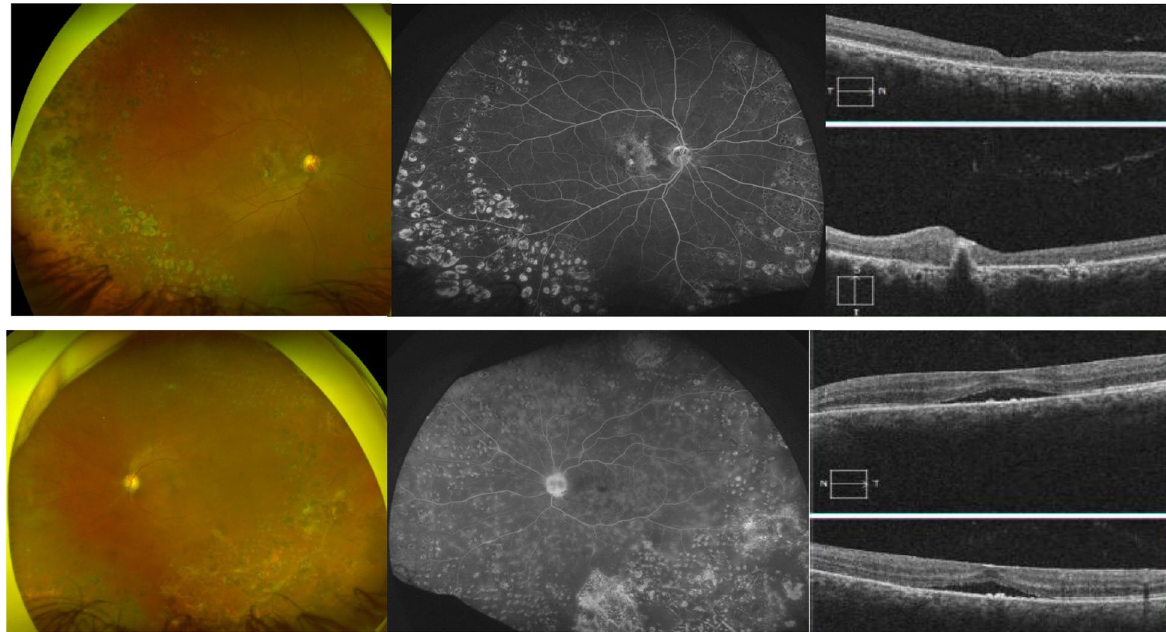
Fig. 2 Last follow up Fundus photo, FFA and OCT). Upper column ( right eye): wide field fundus photo showing subtle temporal disc pallor with macular scarring and sheathed vessels more evident at the papillo‑macular bundle and upper arcades. 360 degrees laser marks evident at the periphery. Wide field mid‑ transit FFA showing only staining of the laser and macular scars.OCT macula showing disorganized retinal layers with scarring involving mainly the outer retina and the retinal pigment epithelium (RPE) and focal RPE detachment. Lower column (left eye): wide field colored fundus photo showing more evident disc pallor, diffuse arterial sheathing and peripheral retinal scarring. Wide field FFA imaging showing diffuse significant capillary leakage with staining of the optic disc, peripheral retinal scars and laser marks. OCT macula: showing epiretinal membrane with flattening of the foveal pit, sub‑macular fluid and RPE scarring